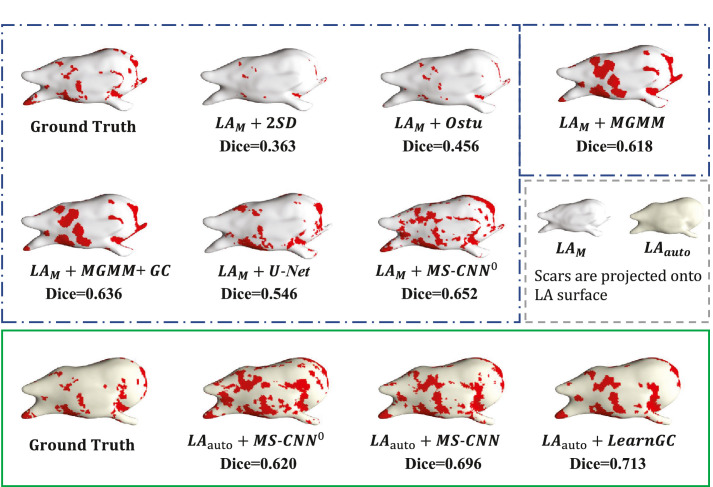
3D visualization of the LA scar classification results using the nine methods. This is the median case selected from the test set in terms of Dice score of scars by the proposed method. The scarring areas are red-colored on the LA surface mesh, which can be constructed either from LAM (LA surface in white) or from LAauto (LA surface in light yellow). (For interpretation of the references to colour in this figure legend, the reader is referred to the web version of this article.)